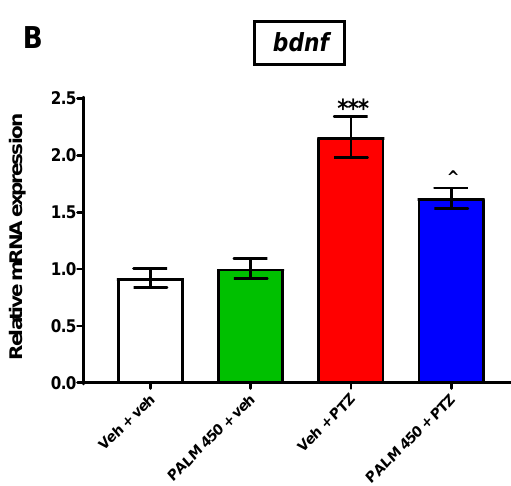
Figure 4. Evaluation of the effect of PALM (450 µM) on seizure-related markers expression in 7 dpf zebrafish larvae. PALM decreased PTZ-induced ( A ) c-fos and ( B ) bdnf upregulated expression. Data were analyzed using one-way ANOVA with the Tukey’s post-hoc test or Student’s t -test. Data are depicted as a mean ± SEM ( n = 4/group, twice replicated). *** p < 0.001 vs. Veh + veh; ^^ p < 0.01, ^ p <